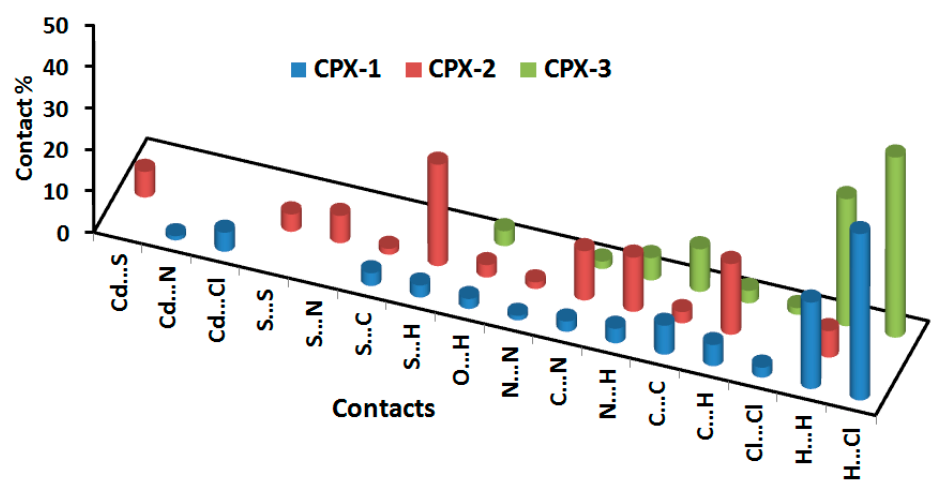
Figure 11. Summary of the intermolecular interactions and their percentages in the crystal structure of the studied Cd(II) complexes. Contacts with percentages less than 1% were omitted from this illustration for more